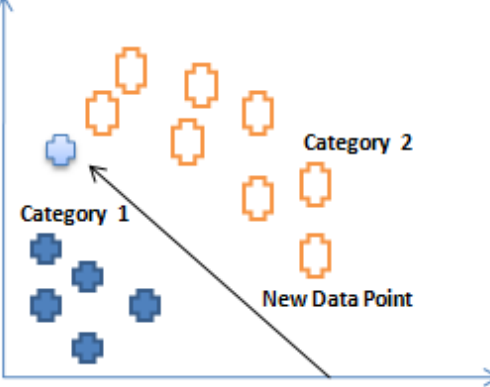
Figure 6. KNN machine learning algorithm.